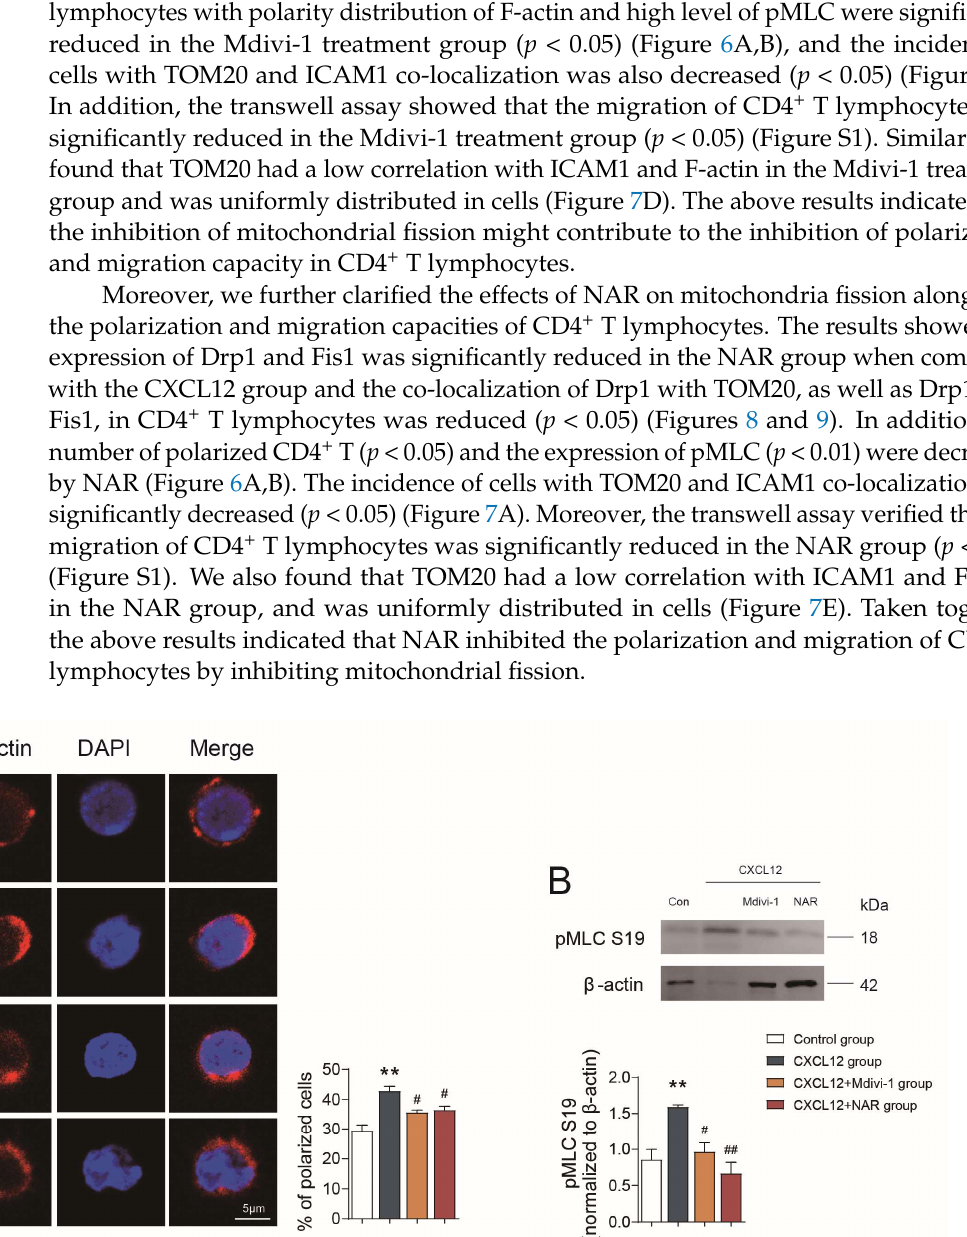
Figure 7. NAR inhibited the mitochondrial distribution and migration of primary CD4 + T lympho- cytes. ( A ) Mitochondria (TOM20) and the uropod marker ICAM1 in different groups. The percent- age of cells with co-localized mitochondria and ICAM1 is reported in the graph (n = 3 mice per group). Control group ( B ), CXCL12 group ( C ), CXCL12 + Mdivi-1 ( D ), CXCL12 + NAR ( E ) CD4 + T